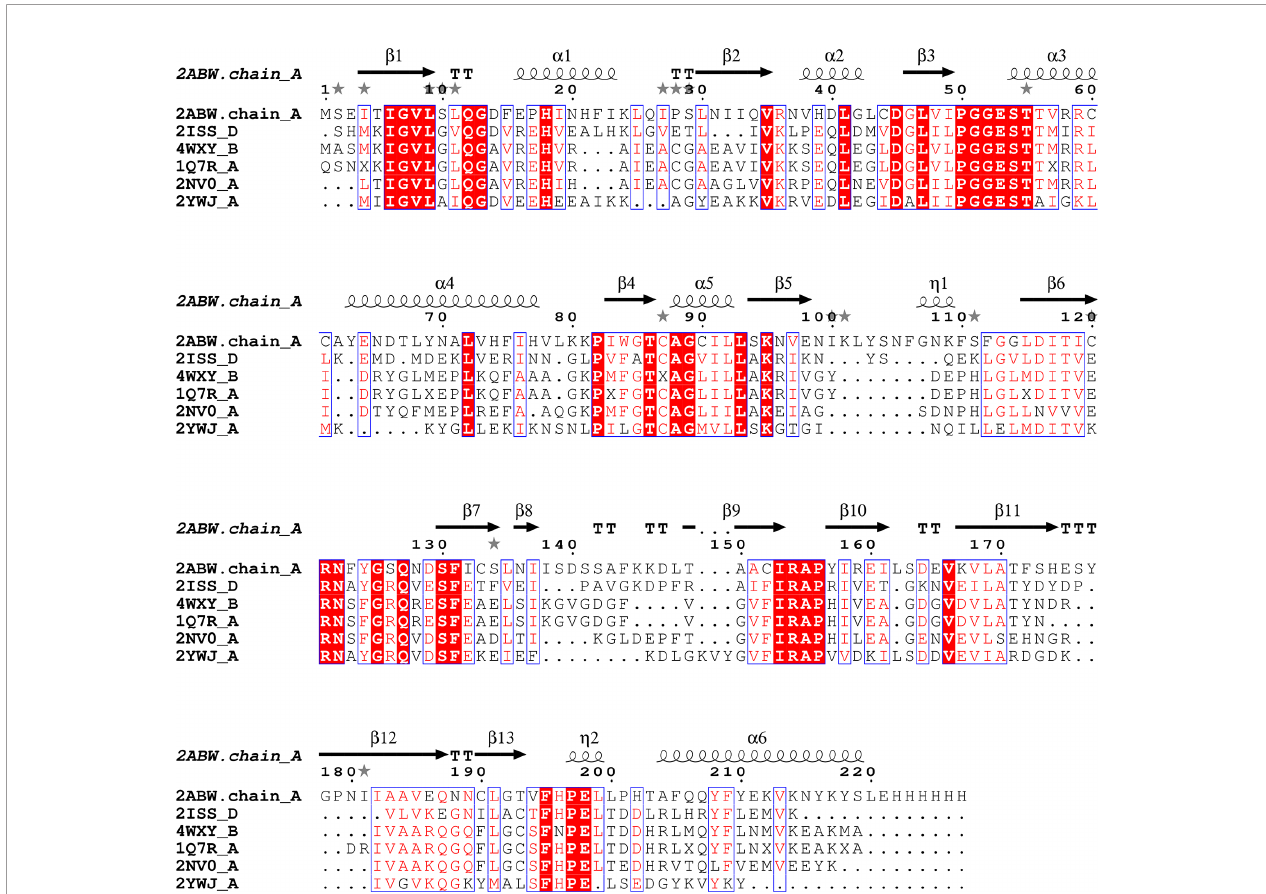
FIGURE 4 | Sequence alignment for Pdx2 enzymes. Alignment prepared with UCSF Chimera (Pettersen et al., 2004) and EPPript (Robert and Gouet,